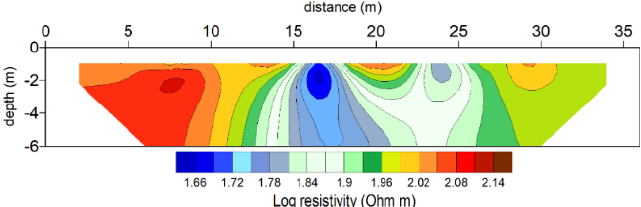
Figure 4. Section resulting from the estimation of 𝜌 (cid:3040) with a linear best ‐ fit procedure applied point by point to the resistivity values belonging to the PERTI sections in Figure 2.